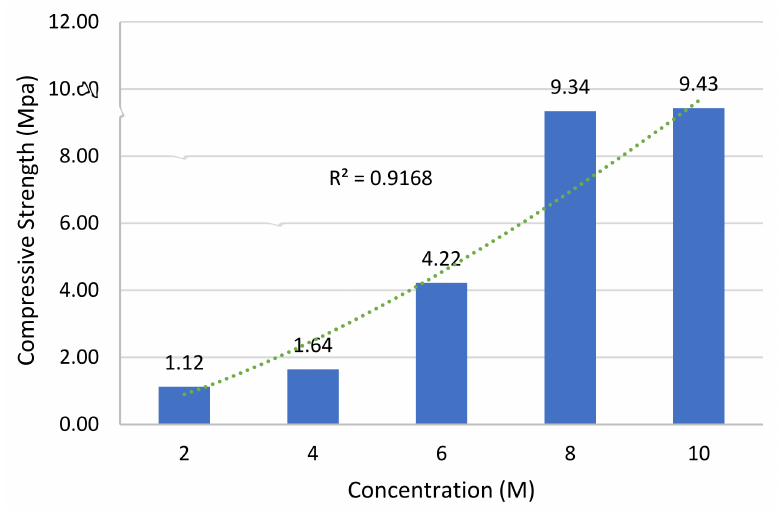
Figure 2. Effect of NaOH concentration on average 72 h compressive